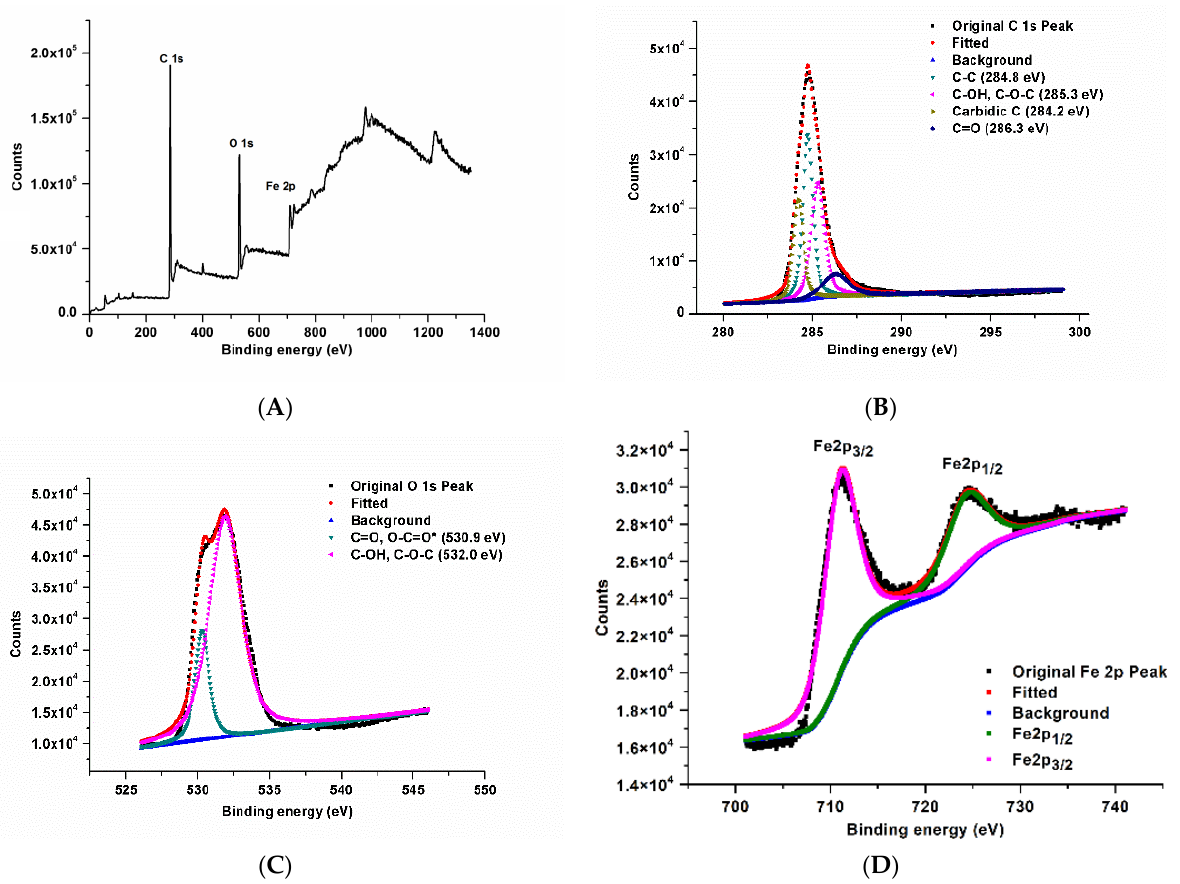
Figure 3. Original XPS spectrum of the Fe 3 O 4 @C nanoparticles EAc NH3 -280 ( A ) , XPS spectrum of C 1s peak ( B ), XPS spectrum of O 1s ( C ), XPS spectrum of Fe 2p ( D ). Table 2. Experimental C 1s and O1s binding energy (BE eV)/chemical state assignments for the as-synthesized nanoparticles.